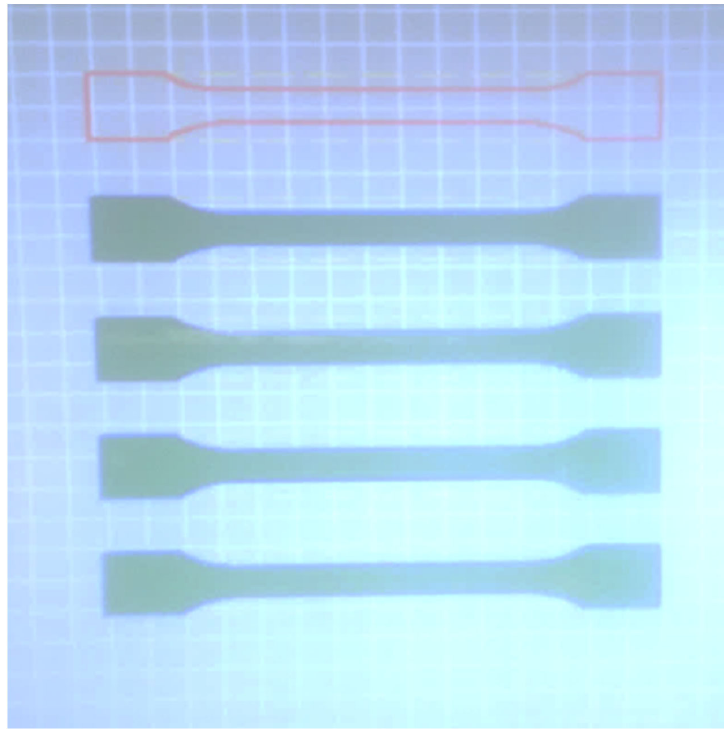
Figure 6. The set of test coupons at predetermined positions . Table 3. Parameters for recyclability of Laser PP CP 75 .